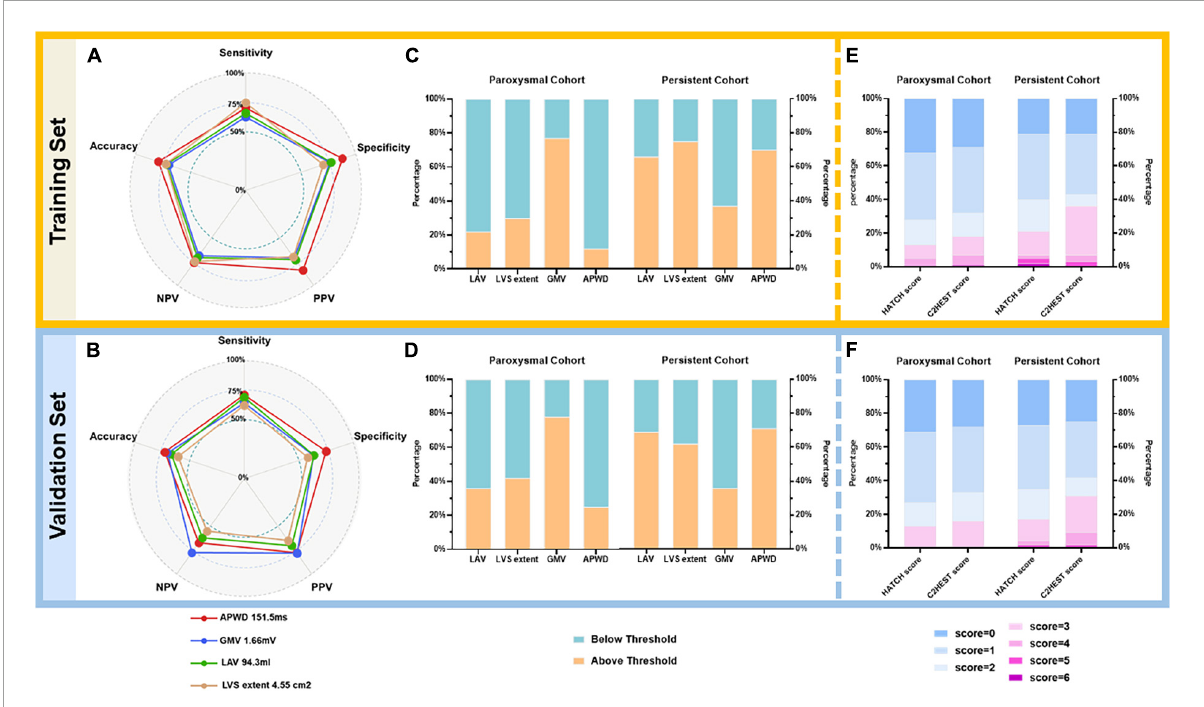
FIGURE8 Diagnostic performance of models using respective optimal thresholds in training (A,C,E) and validation (B,D,F) sets. In the left panel (A,B) , a pentagon is generated for training and validation sets, respectively, to illustrate the diagnostic performance of each model using respective thresholds as listed on the legend at bottom. Every pentagon contains three reference levels (dashed circles), representing 50, 75, and 100%, respectively. The middle panel (C,D) illustrates the percentage of individuals above (orange) or below (emerald) respective AF-persistency thresholds of each model in paroxysmal and persistent cohorts. For LAV, LVS extent, and APWD, individuals above respective thresholds are diagnosed as positive for persistent AF, whereas for GMV, those below the threshold are diagnosed as positive for persistent AF. In the right panel (E,F) , the diagnostic performance of HATCH score and C2HEST score is illustrated as stacked barplots, the percentage of different scores is displayed as bars from blue (lowest risk) to purple (highest risk) with 1-score increment, as the legends at the bottom. LAV, left atrial volume; LVS, low voltage substrate; GMV, global mean voltage; APWD, duration of the amplified digital P-wave; NPV, negative predictive value; PPV, positive predictive value.